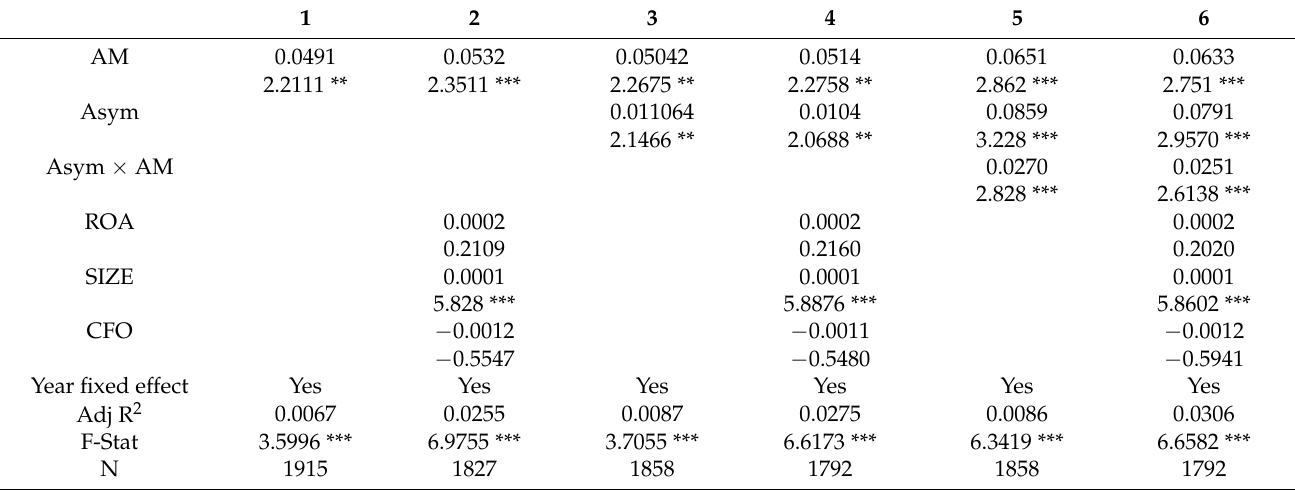
Table 4. The Impact of Accrual Management on Firm-Specific Risk (CAPM Discretionary